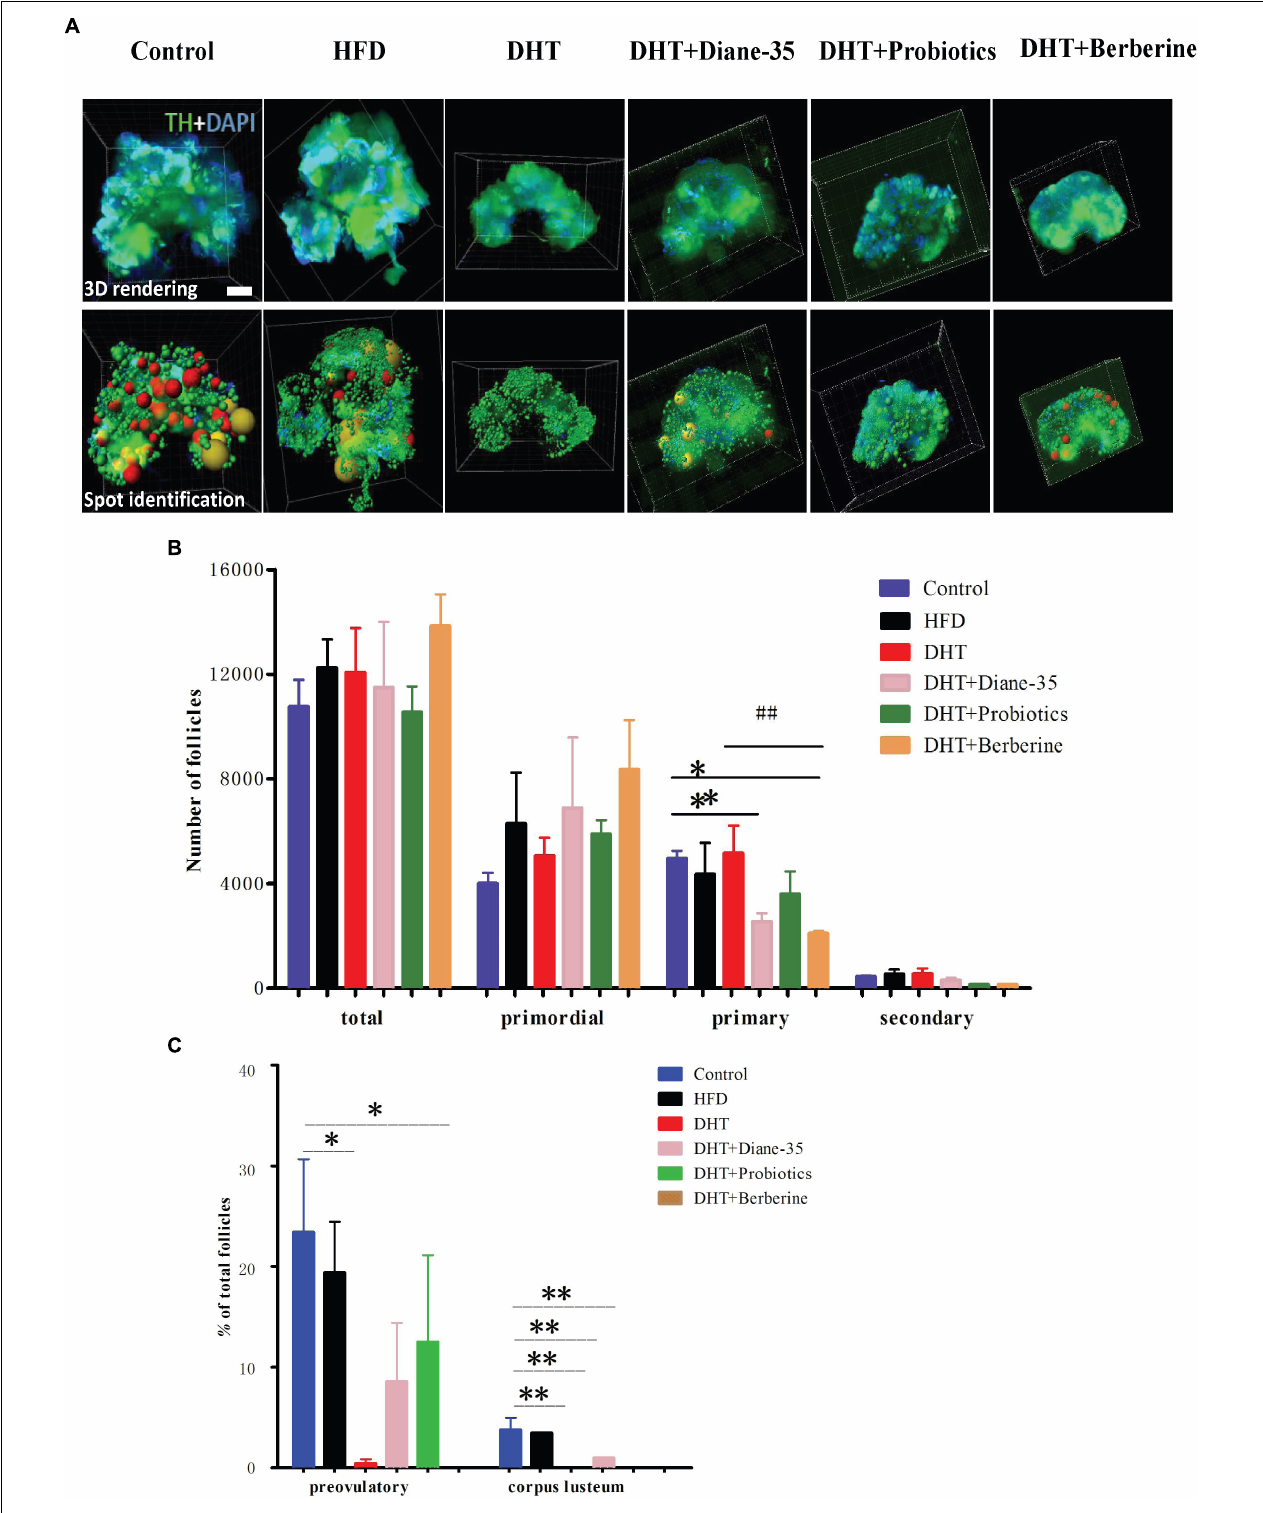
FIGURE 3 | (A) 3D rendering after staining by TH and DAPI, with the bottom row showing the spot identification at the different follicle stages. Different stages of follicles are represented as different colors of spheres, of which the red and yellow represent preovulatory follicles and corpora lutea, respectively. (B) The numbers of total follicles and follicles at different stages in the six groups. (C) The percentages of different follicle stages in the six groups. TH, tyrosine hydroxylase; CL, corpus luteum. ∗ p < 0.05, ∗∗ p < 0.01 vs. control, ## p < 0.05 vs. DHT.